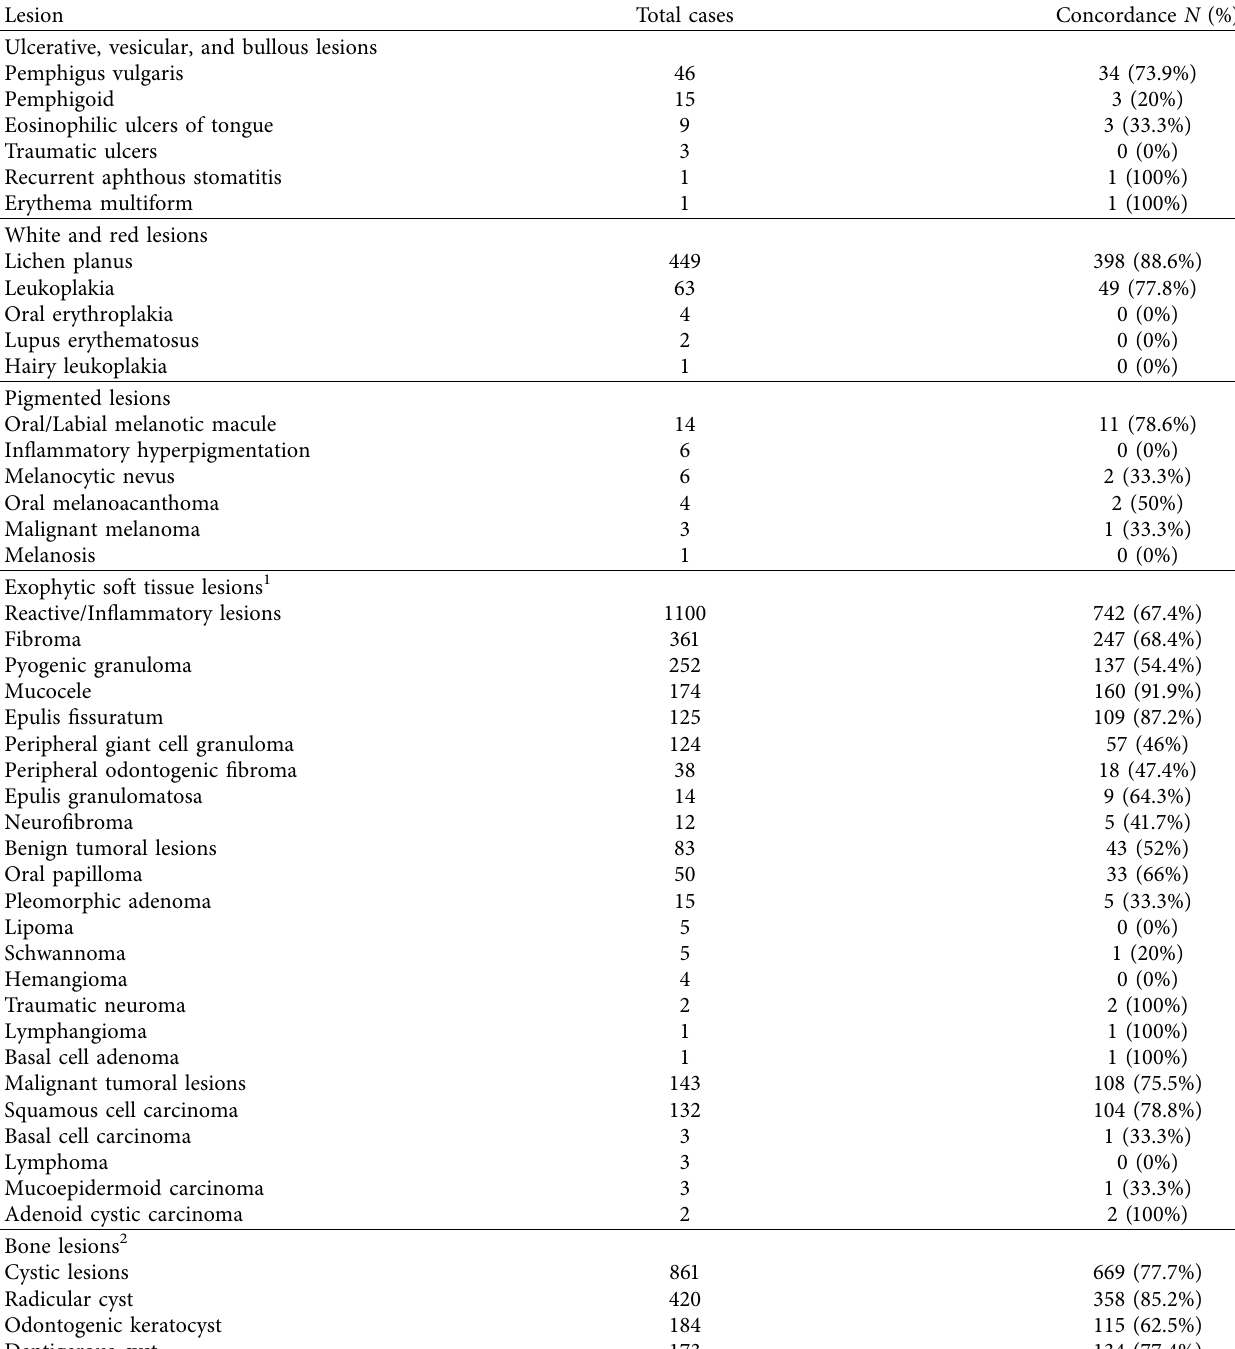
Table 4: Frequency and concordance rate of clinical and histopathologic diagnosis in each category of lesions.